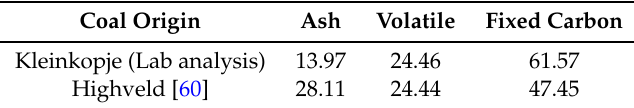
Table 4. Proximate analysis (weight % dry basis).